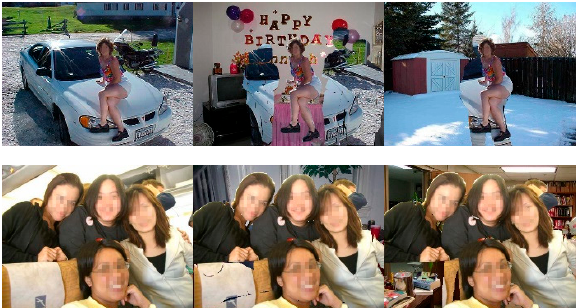
Figure 6. Two examples of domain randomization. In each row, the left image denotes the original image, the middle and the right ones show two modified images with different backgrounds.